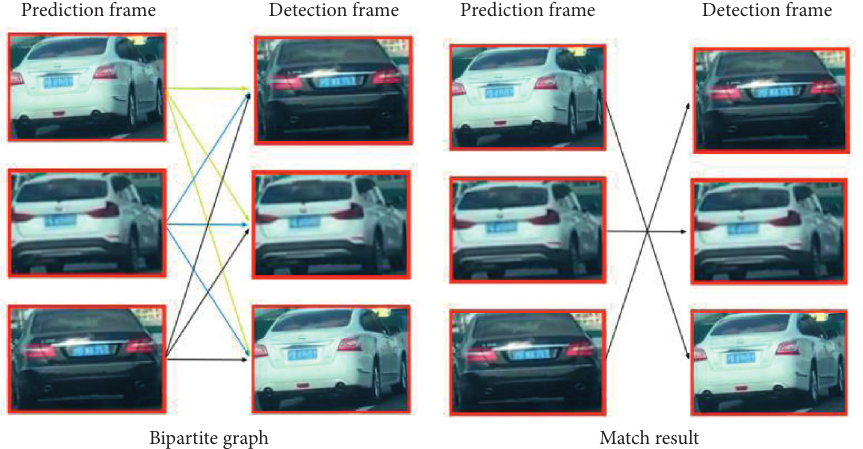
Figure 5: Object matching between frames based on the Hungarian algorithm. (a) Bipartite graph. (b) Match result.